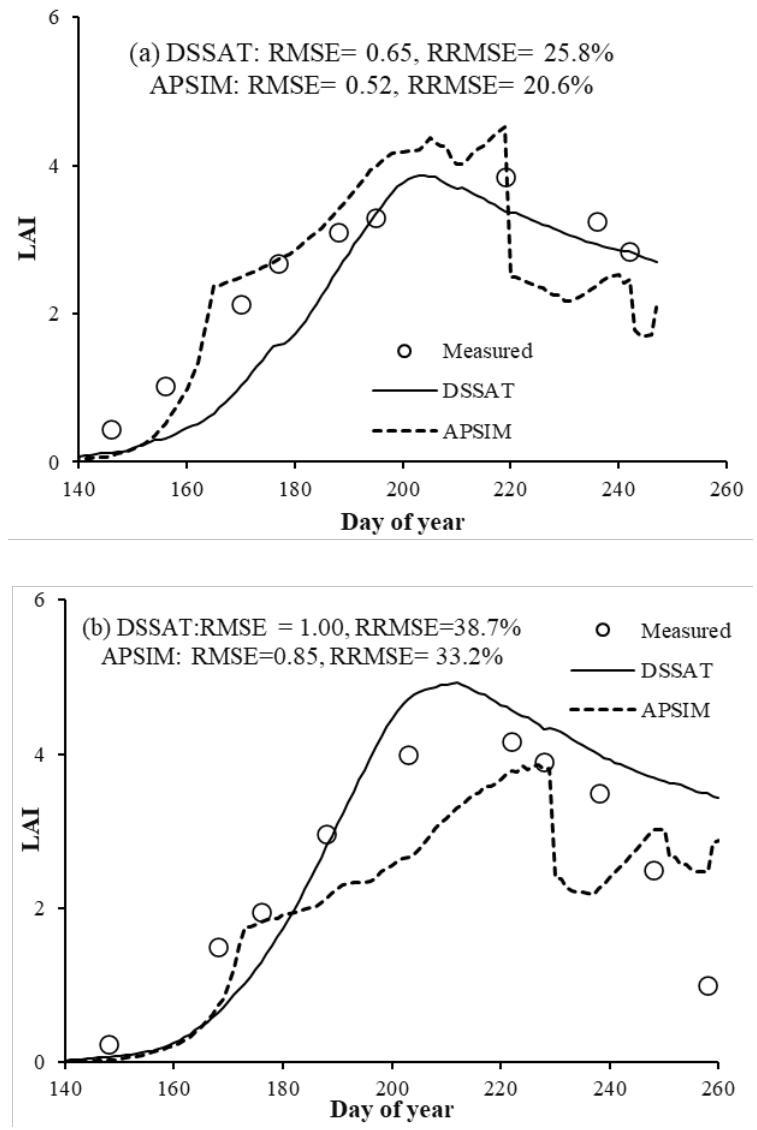
Figure 1. Observed and simulated leaf area index under cotton production for the calibration during ( a ) 2017 and validation during ( b ) 2018 growing seasons. ( a ) 2017 and validation during ( b ) 2018 growing